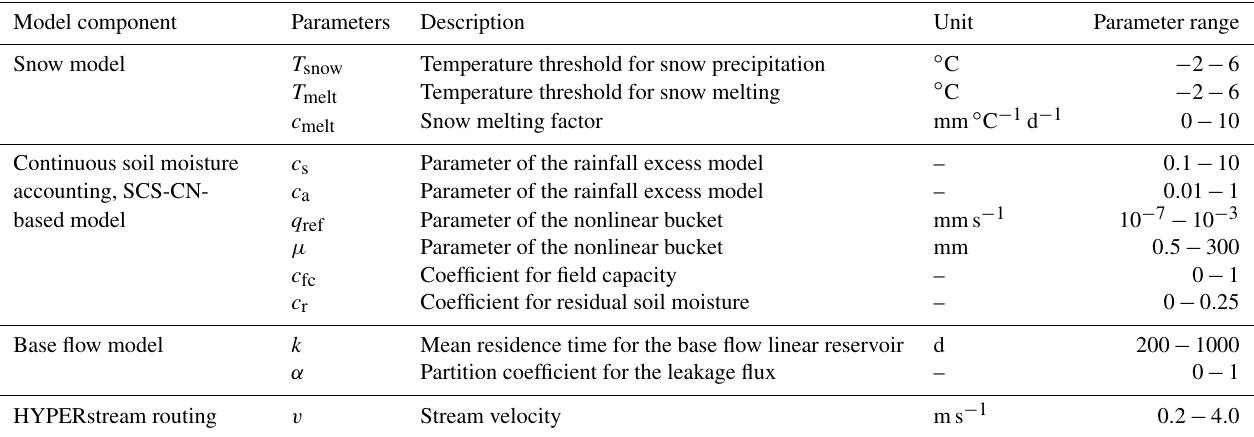
Table 1. List of model parameters with their units and parameter range. Model